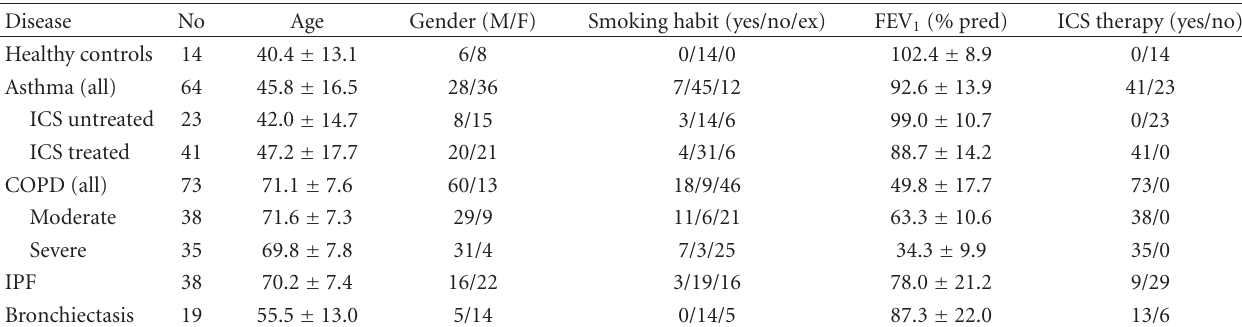
Table 1: Main characteristics of the groups under